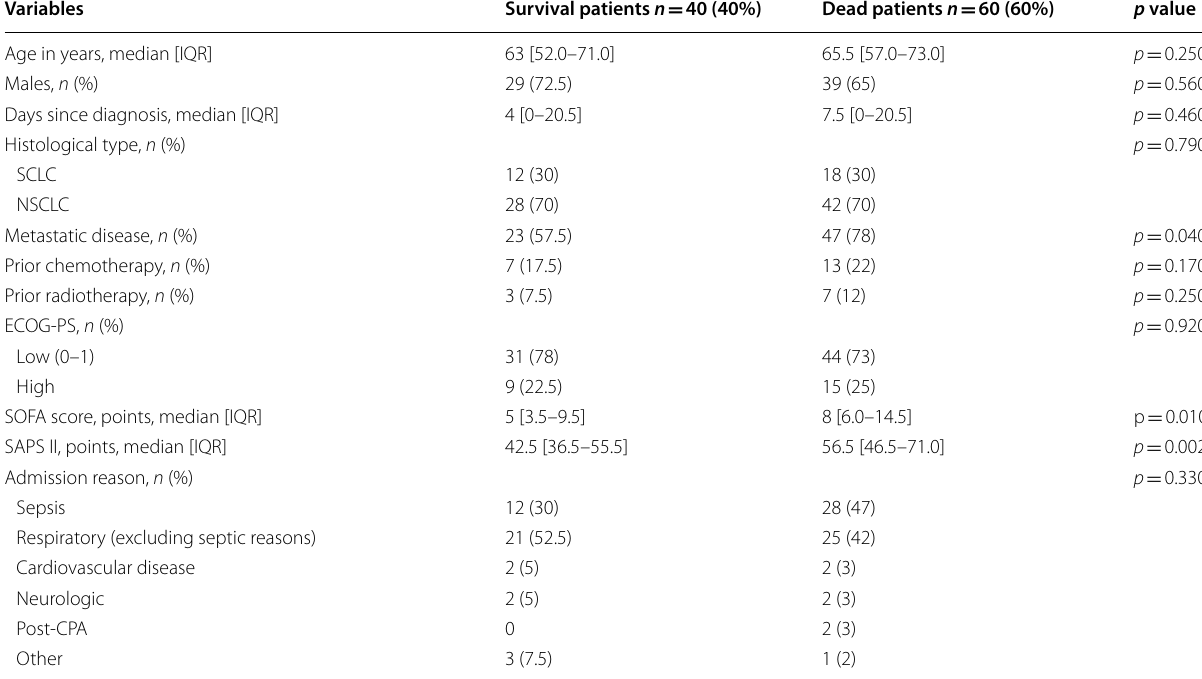
Table 2 Univariate analysis of risk factors associated with hospital mortality